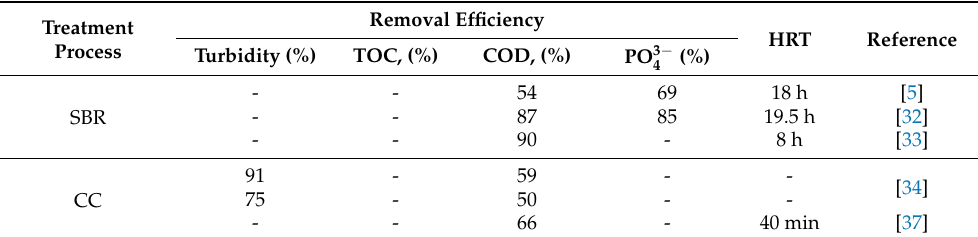
Table 6. Summary of studies on BWW